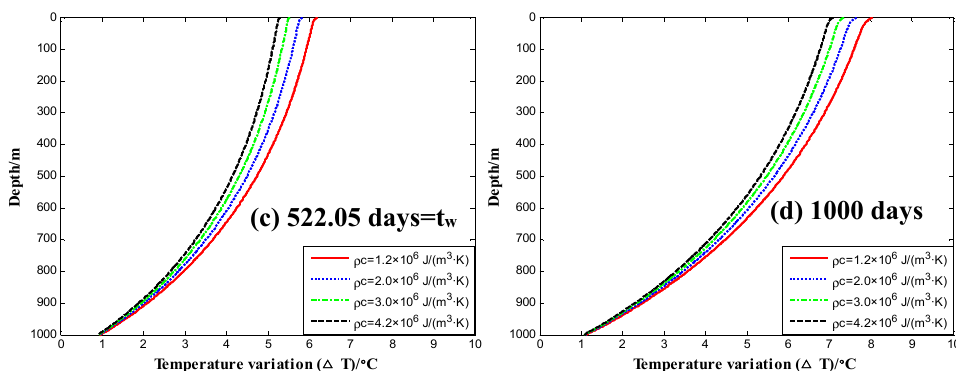
Figure 18. Overburden temperature variation at the wellbore-formation interface ( r = 0.14 m, 0 m ≤ z ≤ 1000 m) with a different volumetric heat capacity ( VHC). ( a ), ( b ), ( c ), ( d ) are the temperature profiles of 20, 50, 522.05, 1000 days of production time, respectively.